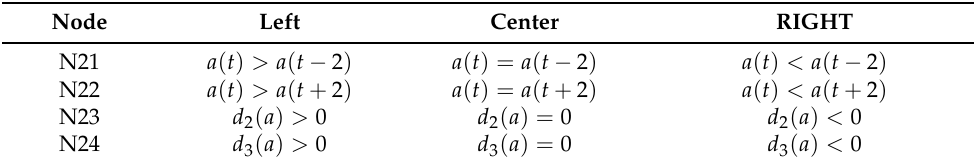
Table 9. Optimization experimentally obtained results for O C .